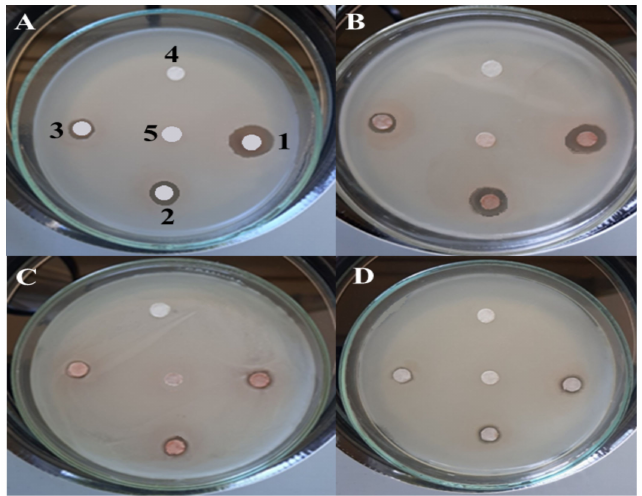
Figure 1. Antimicrobial activity of grape seed extracts against S. aureus (zone 1, 0.50 mg/mL extract; zone 2, 0.25 mg/mL; zone 3, 0.10 mg/mL; zone 4, 0.05 mg/mL; zone 5, negative control: ( A ) Pinot Noir, ( B ) Marselan, ( C ) Cabernet Sauvignon, and ( D ) Tamyanka.